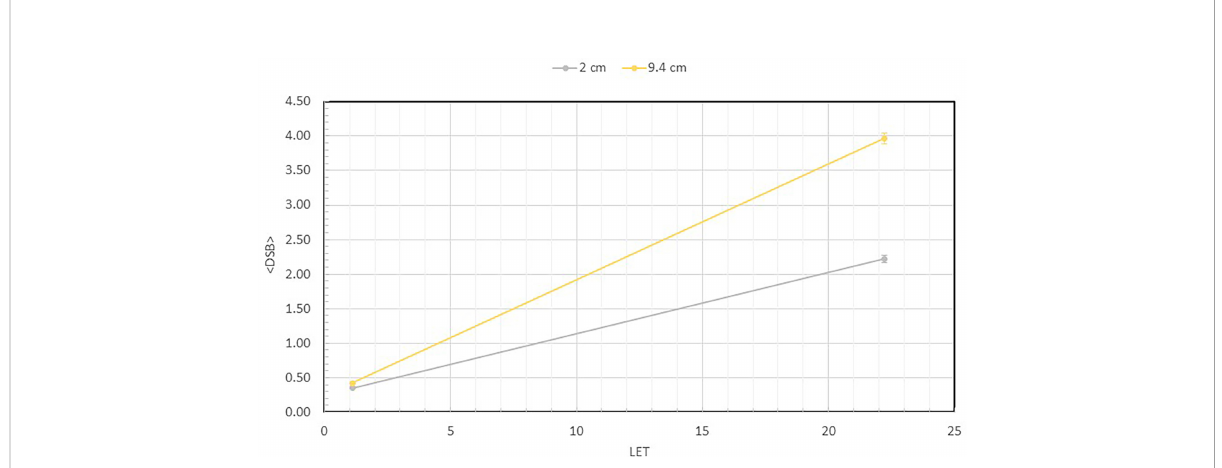
FIGURE 4 Average number of DSBs per DNA at 2 ad 9.4 cm for both 1000 Gy and 3000 Gy. They are plotted as a function of LET, which shows value of 1.1 keV/µm at 2 cm and 22.6 keV/µm at 9.4 cm depth. This quantity is calculated as the total number of broken DNA fragments divided by the total number of DNA molecules described in Figure 3 for each